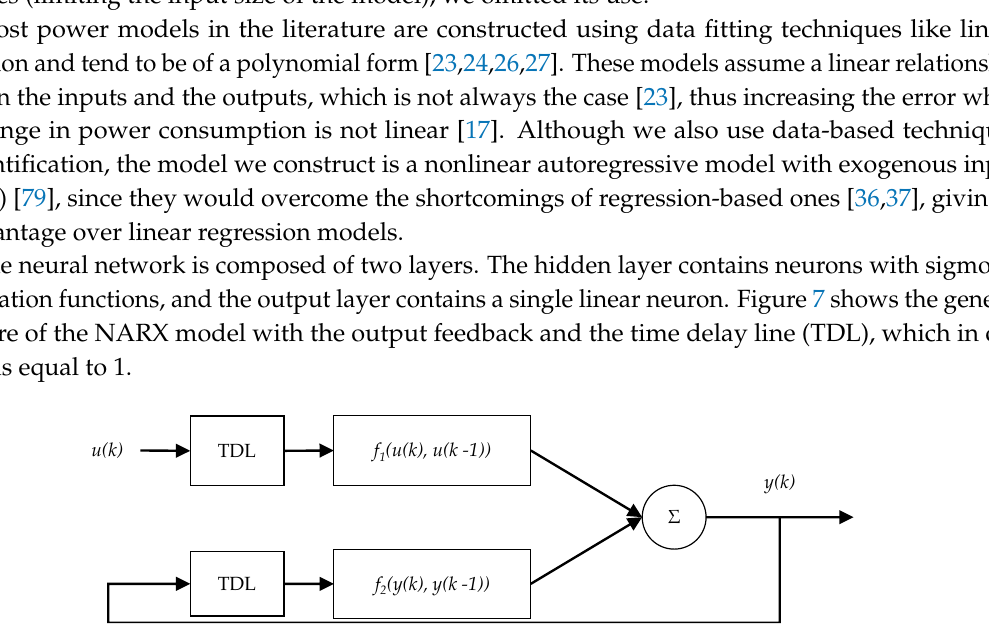
Figure 7. The general structure of the NARX neural network model. TDL: Time Delay